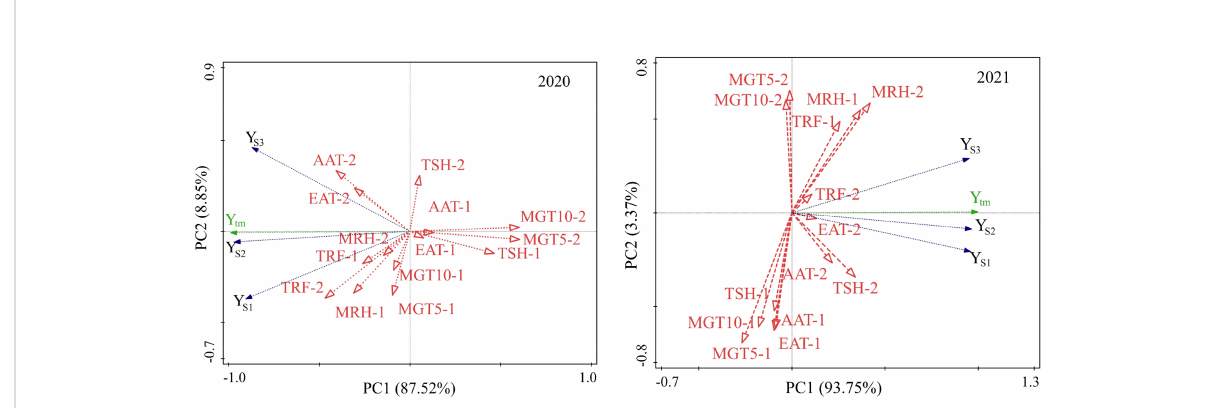
FIGURE 6 RDA analysis of yields on sowing dates in response to climatic factors during emergence to fl owering and fl owering to maturity in 2020 (left) and 2021(right). EAT, effective accumulative temperature; AAT, accumulative average temperature; AGT5, average 5-cm ground temperature; AGT10, average 10-cm ground temperature; ARH, average relative humidity per day; TRF, total rainfall; TSH, total sunshine. -1, stage from emergence to fl owering; -2, stage from fl owering to mature.